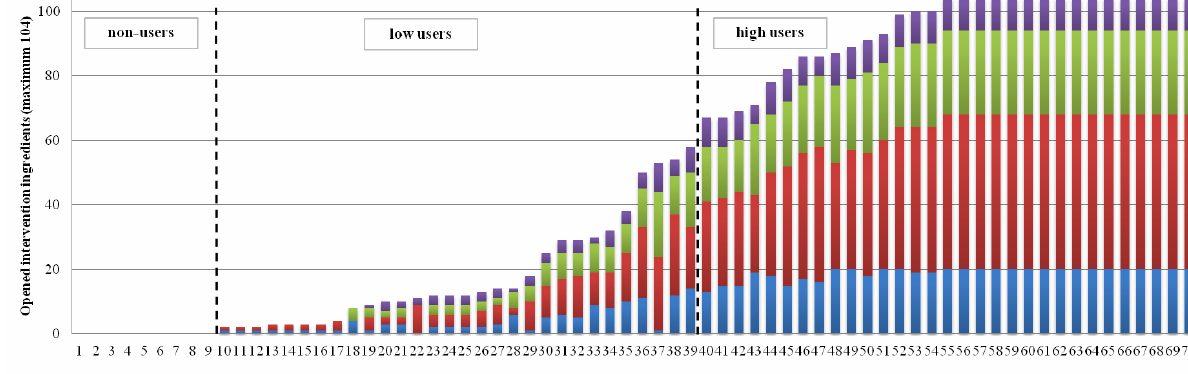
Table 2. On baseline distress, sociodemographic, and medical characteristics, no significant differences were found between nonusers versus users (low and high users), and low users versus high users.